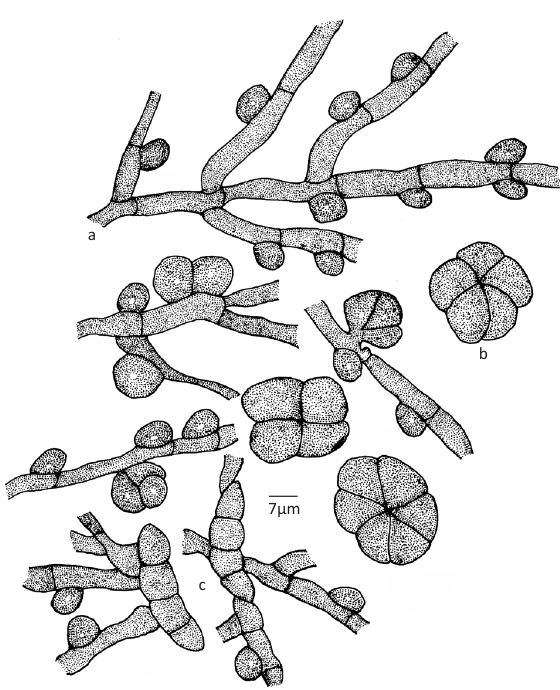
Figure 15. Sarcinella securinegae sp. nov. a - Appressoriate mycelium; b - Conidia of Sarcinella ; c - Germinating conidia of